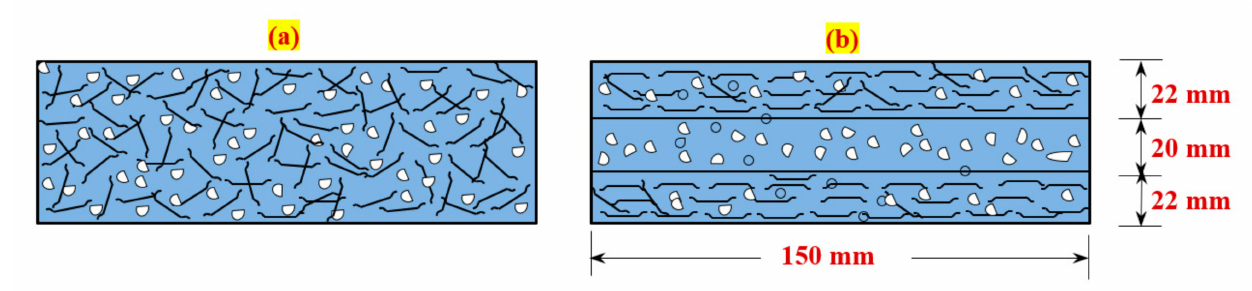
Figure 17. Fiber alignment or orientation in concrete: ( a ) three-dimensional, ( b )